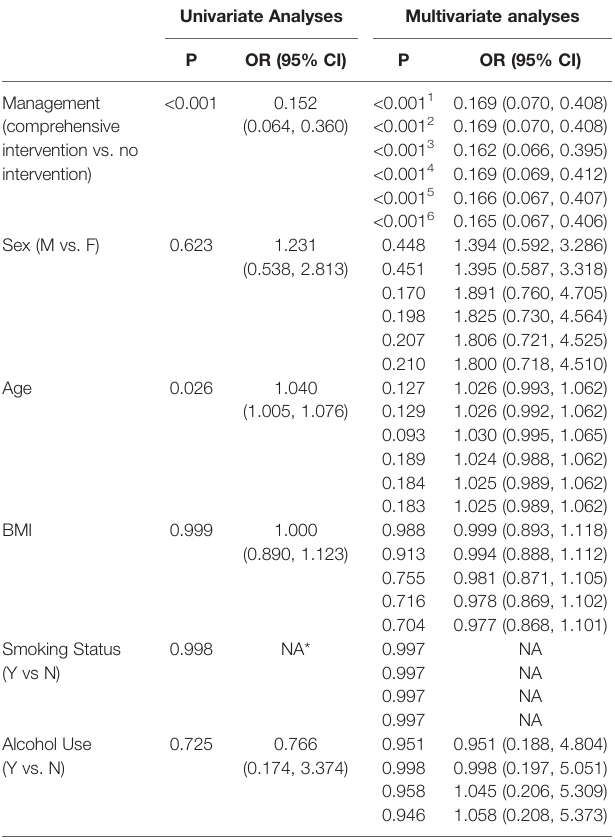
TABLE 3 | Univariate Analysis and Multivariate Analyses for the Positive RT-PCR